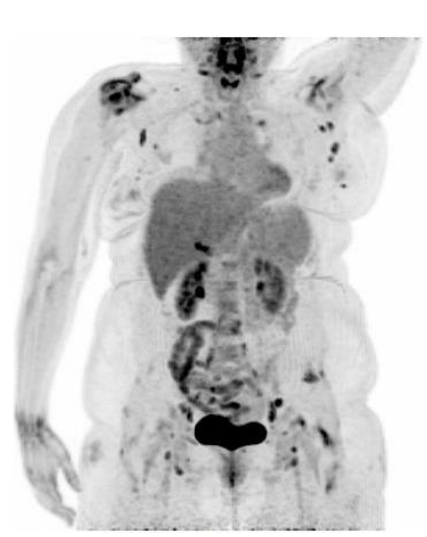
Figure 1. A 50-year old woman of Indian descent living in Denmark, with a prior history of knee arthrosis, presented with fever, myalgia and arthralgia which had developed during a return visit to New Delhi, India. Two weeks after returning to Denmark the generalised arthralgia and myalgia persisted to a degree where the patient was mainly confined to her bed. The symptoms